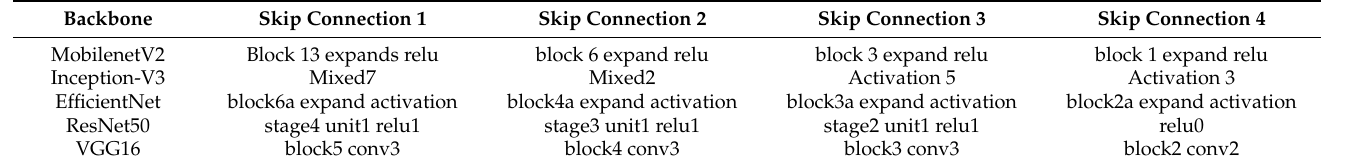
Table 1. Backbone networks and skip connections used in the proposed DCDNet network.